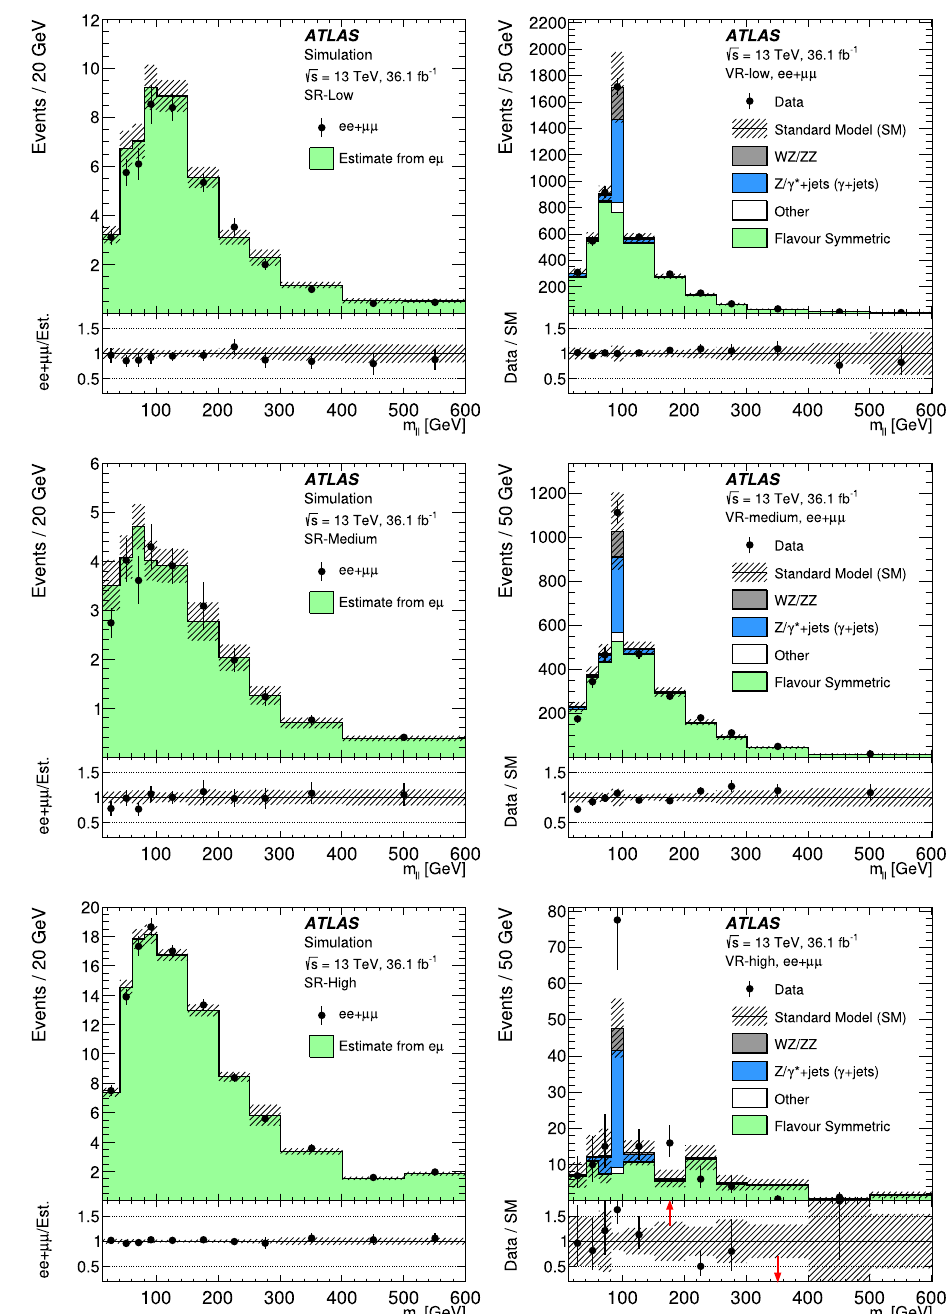
Fig. 4 Validation of the flavour-symmetry method using MC simula- tion (left) and data (right), in SR-low and VR-low (top), SR-medium and VR-medium (middle), and SR-high and VR-high (bottom). On the left the flavour-symmetry estimate from t ¯ t , Wt , WW and Z → ττ MC samples in the e μ channel is compared with the SF distribution from these MC samples. The MC statistical uncertainty is indicated by